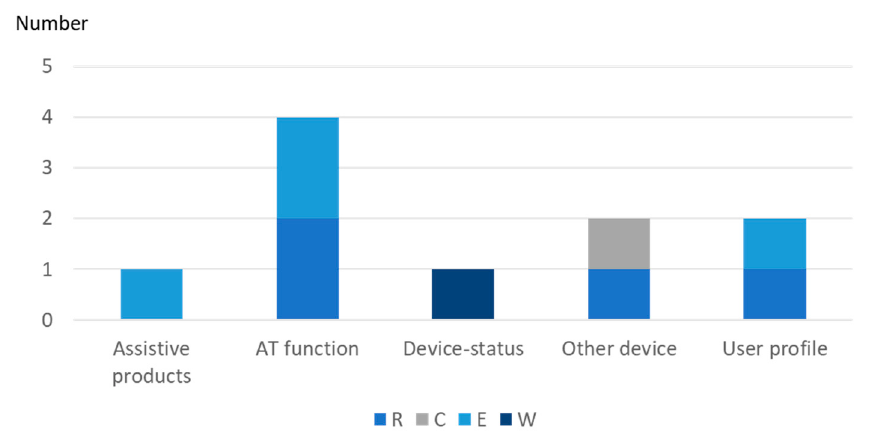
Figure 4. Numbers of context factors by provisions and guidelines.